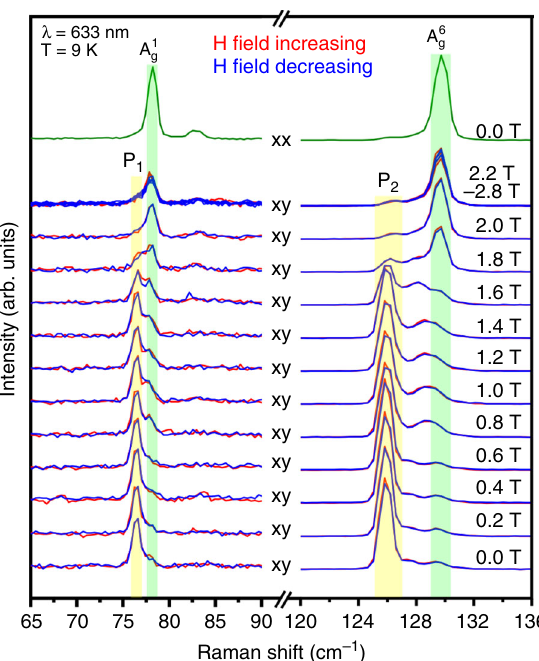
Fig. 2 Magnetic fi eld-dependent Raman spectra of CrI 3 . Spectra are shown from 0 T to 3 T ( B ⊥ ab plane) at T = 9 K where P 1 and P 2 disappear and A 6 appear despite being forbidden in the above B = 2.0 T, whereas A 1 g g xy polarization con fi guration. Yellow (green) shading highlights changes in P 1 , P 2 (A 1 , A 6 ) as the magnetic fi eld is varied. A vertical offset was applied g g to spectra at different fi eld values. xx spectrum at B = 0 T shown at top for comparison.